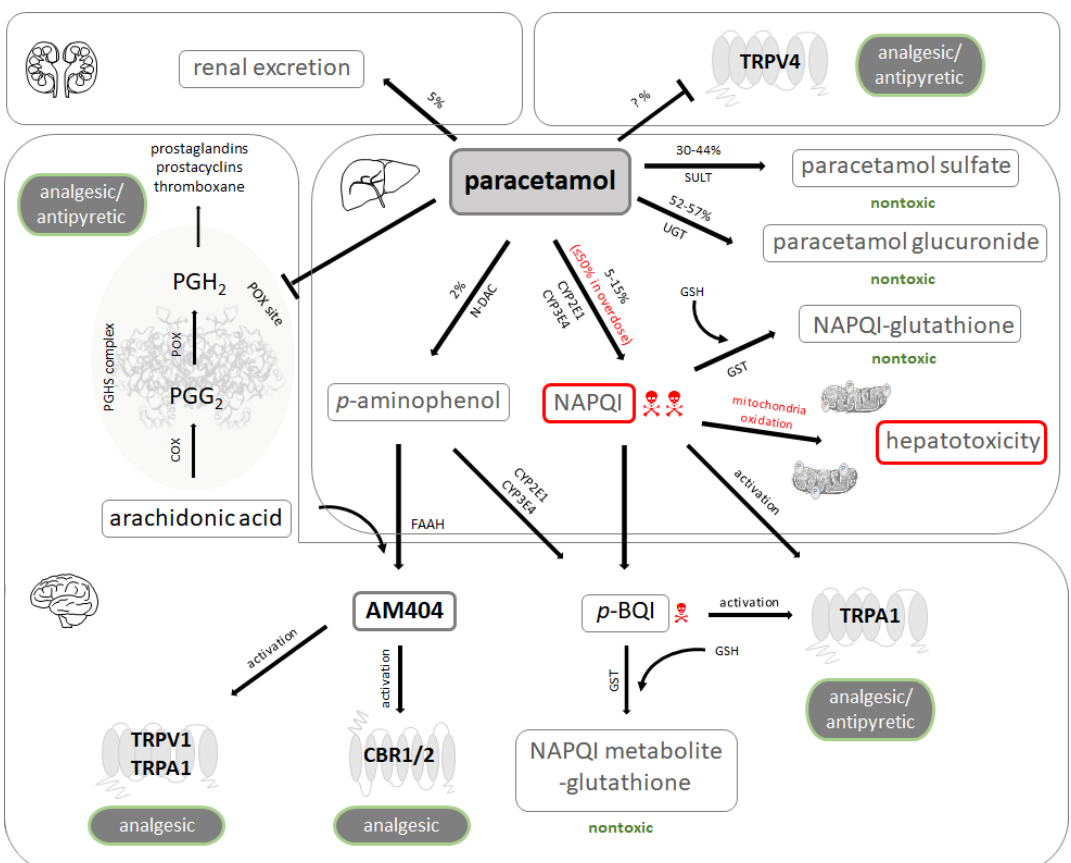
Figure 2. Paracetamol metabolism and pharmacology. Unchanged paracetamol (acetaminophen) is excreted in the urine to a small extent. It may also act as an antagonist of the vanilloid-subtype 4 receptors (TRPV4) in various tissues. Paracetamol is mainly metabolized in the liver. The metabolites generated by glucuronidation and sulfation are not toxic and subject to urinary excretion, while a minor fraction undergoes oxidative metabolism. This results in formation of N -acetyl- p -benzo-quinone-imine (NAPQI), a highly toxic intermediary produced by cytochrome P450 enzymes. NAPQI builds adducts with mitochondrial proteins and induces oxidative stress, nuclear DNA fragmentation, and subsequent cell necrosis. Paracetamol is becoming de-acetylated to p -aminophenol, which in turn is metabolized by the hepatic microsomal cytochrome P450 enzyme system to the toxic compound p -benzoquinone ( p -BQI). Under physiological conditions, detoxification of NAPQI and p -BQI occurs by binding to glutathione (GSH) and subsequent renal excretion. The prostaglandin endoperoxide H synthase (PGHS) complex consists of a cyclooxygenase (COX) and a peroxidase (POX) moiety. Arachidonic acid is first transformed to the unstable prostaglandin G 2 (PGG 2 ) by COX, which is further reduced to prostaglandin H 2 (PGH 2 ) by POX. PGH 2 gives rise to various endogenous regulators such as prostaglandins, prostacyclins, and thromboxane. Paracetamol induces analgesia and antipyresis by blocking prostaglandin synthesis at the POX site of PGHS complex. p -aminophenol undergoes conjugation with arachidonic acid by fatty acid amide hydrolase (FAAH) to N -arachidonoyl-phenolamine (AM404), which is a potent activator of TRPV1 and transient receptor potential ankyrin 1 (TRPA1) as well as a weak agonist of cannabinoid receptors type 1 and 2 (CBR1/2). Activation of these receptors by AM404 may mediate analgesic effects. NAPQI and p -BQI may also produce analgesic and antipyretic effects by activating TRPA1. UGT: